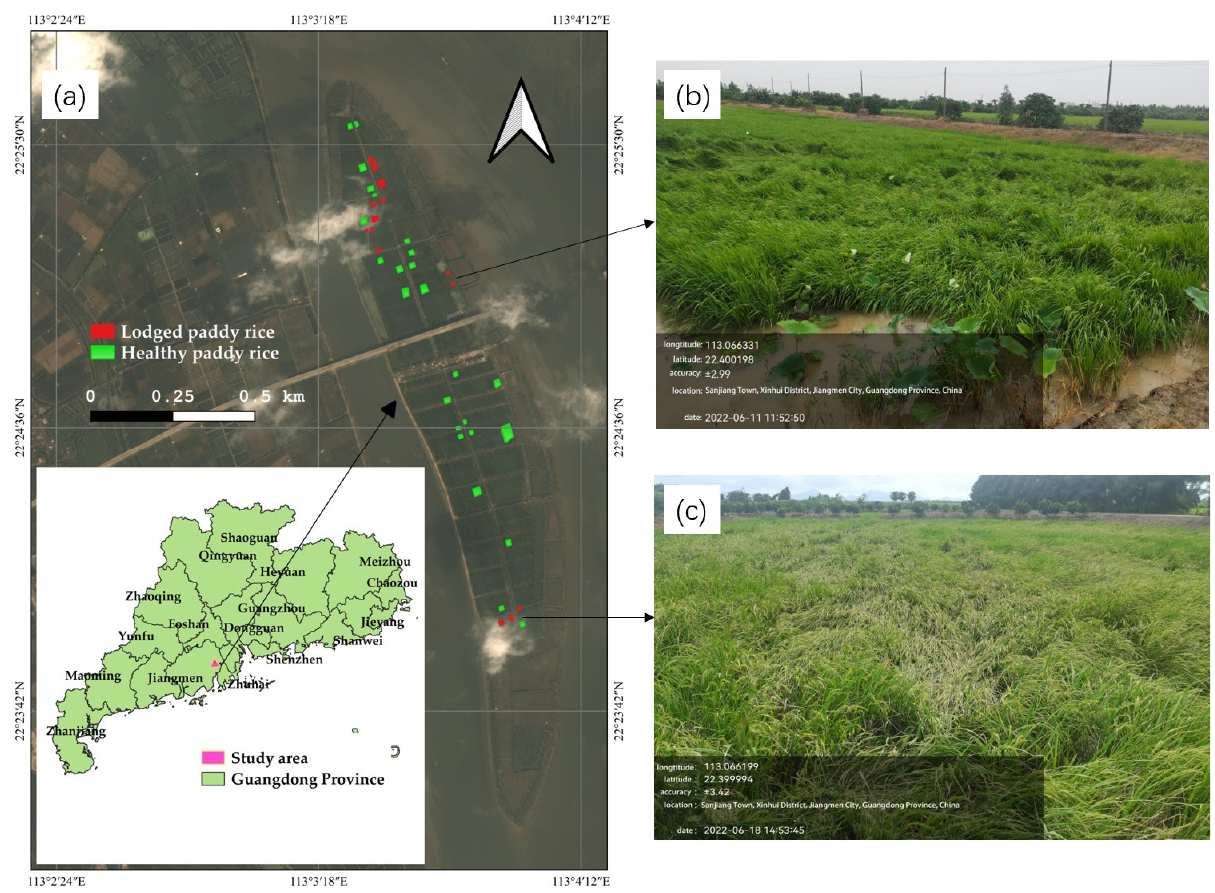
Figure 1. Study area description. ( a ) the location of the study area in Xinhui District, Guangdong Province, China, and the sampling site （ Red is the lodging area. Green is a no-lodging area ） ; (